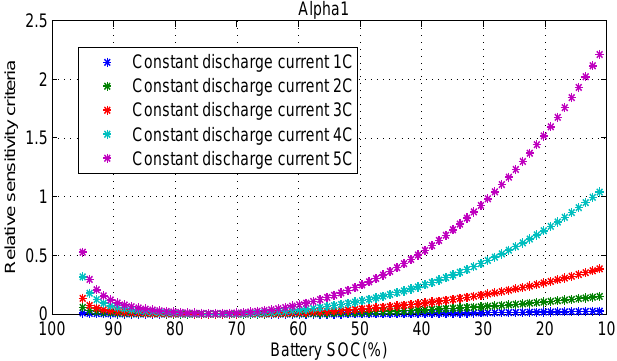
Figure 14. Analysis of index values under different current rates discharge test: the sensitivity index values of sensitive parameter fractional-order factor α 1